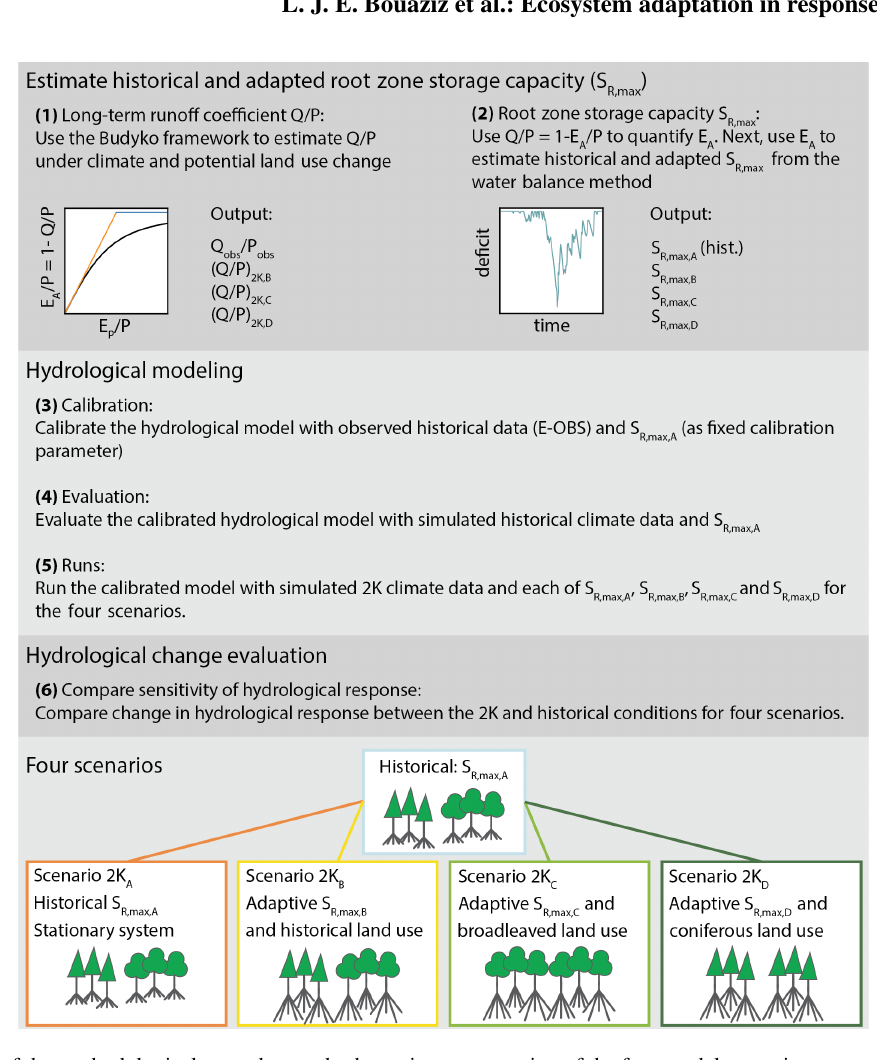
Figure 2. Overview of the methodological procedure and schematic representation of the four model